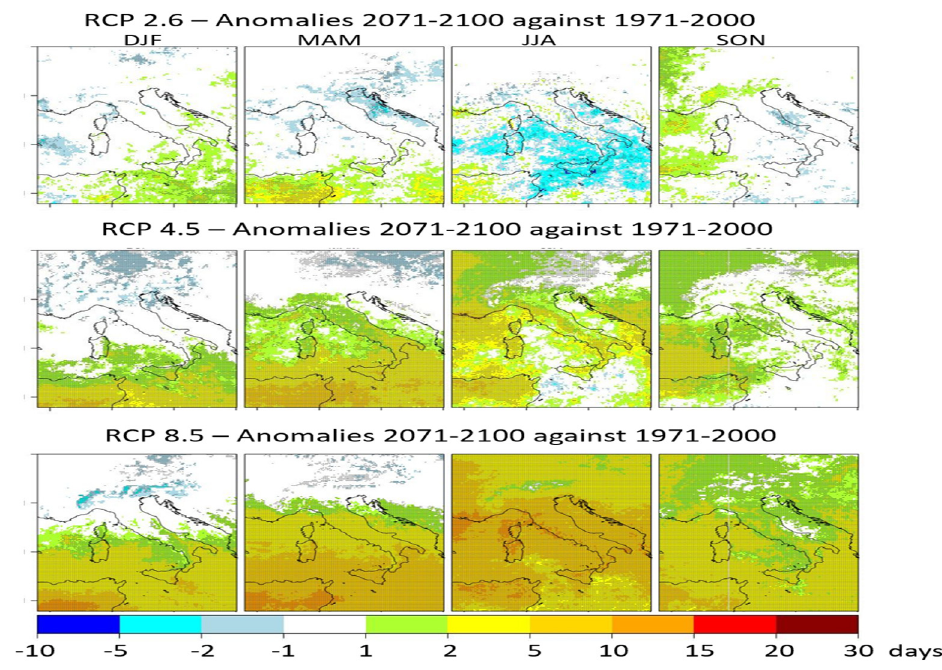
Figure 12. As Figure 10, but for the future scenario 2071–2100.